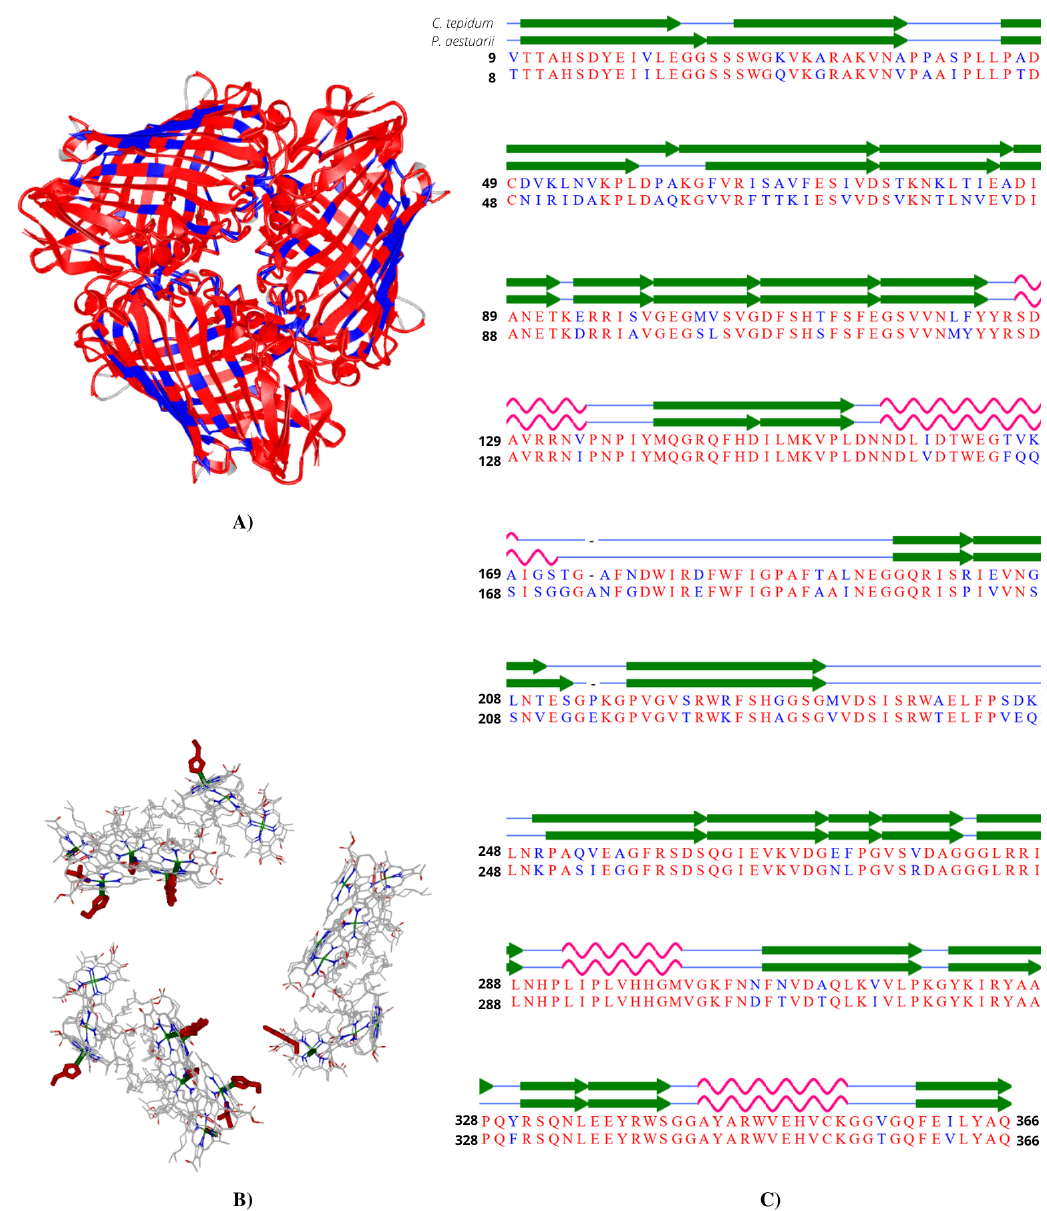
Figure 17. Overlapped protein structure and amino acid sequence for the fmoA gene in FMO complexes of C. tepidum and P. aestuarii . ( A ) Location of peptide differences (blue) and similarities (red) between both structures. ( B ) BChl organization overlapping. ( C ) Linear representation of protein structures showing residues belonging to β -sheets (green arrows) and α -helices (pink curves). Punctual differences in the amino acid sequence (blue) in ( C ) match the sites illustrated in ( A ). Protein Data Bank files 3EOJ ( P. aestuarii ) and 3BSD ( C. tepidum ). Generated using